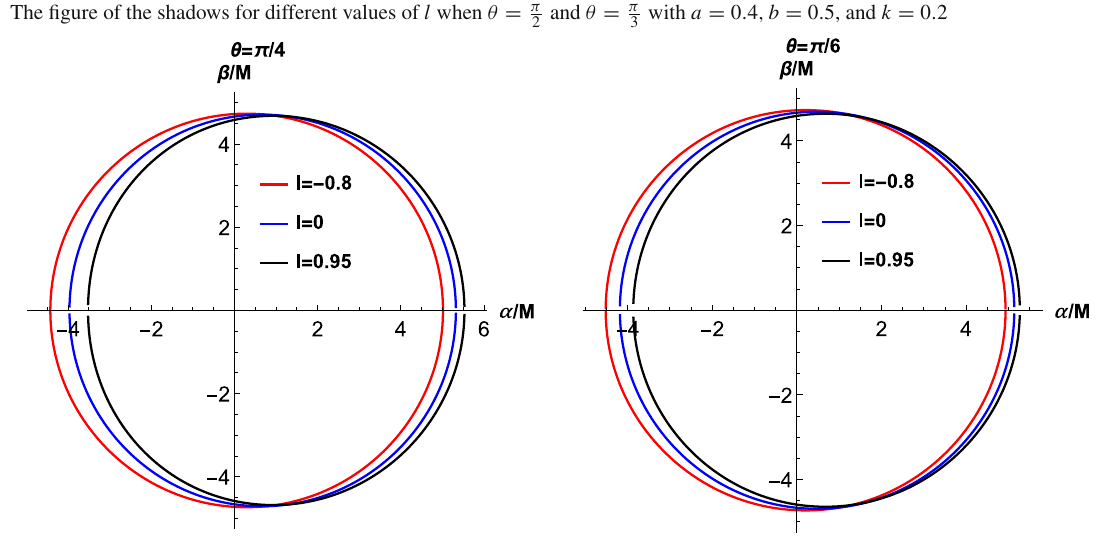
Fig. 7 The figure of the shadows for different values of l when θ = π